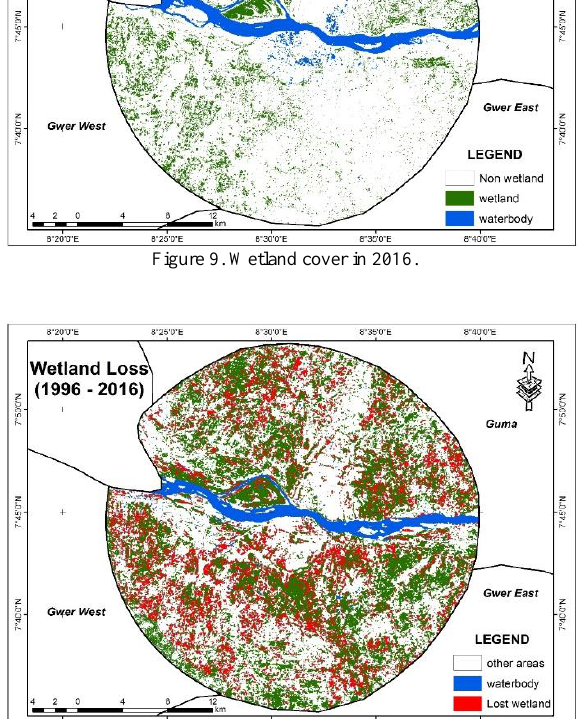
Figure 10. Wetland loss between 1996 and